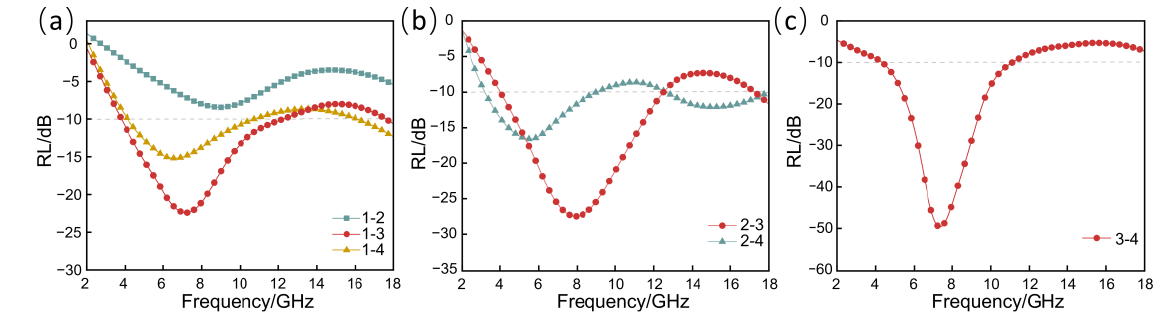
Figure 8. RL curves of double-layer RGO/NW. ( a ) 1-2, 1-3, 1-4; ( b ) 2-3, 2-4; ( c ) 3-4. Multilayer RGO/NW materials designed strictly according to the functional require- ments of the matching, absorbing, and reflecting layers are divided into four types of three layers and one type of four layers. Figure 9 shows the RL at 2 – 18 GHz for the multilayer RGO/NW material. Each curve for the multilayer RGO/NW material in the figure has multiple peaks. It should be noted that the number of RL peaks for sample 1 as a matching layer is one less than the number of layers, i.e., two peaks for the three-layer material and three peaks for the four-layer material. The reason for this phenomenon is that the dielectric properties of sample 1 are too low to complete effective wave absorption alone.